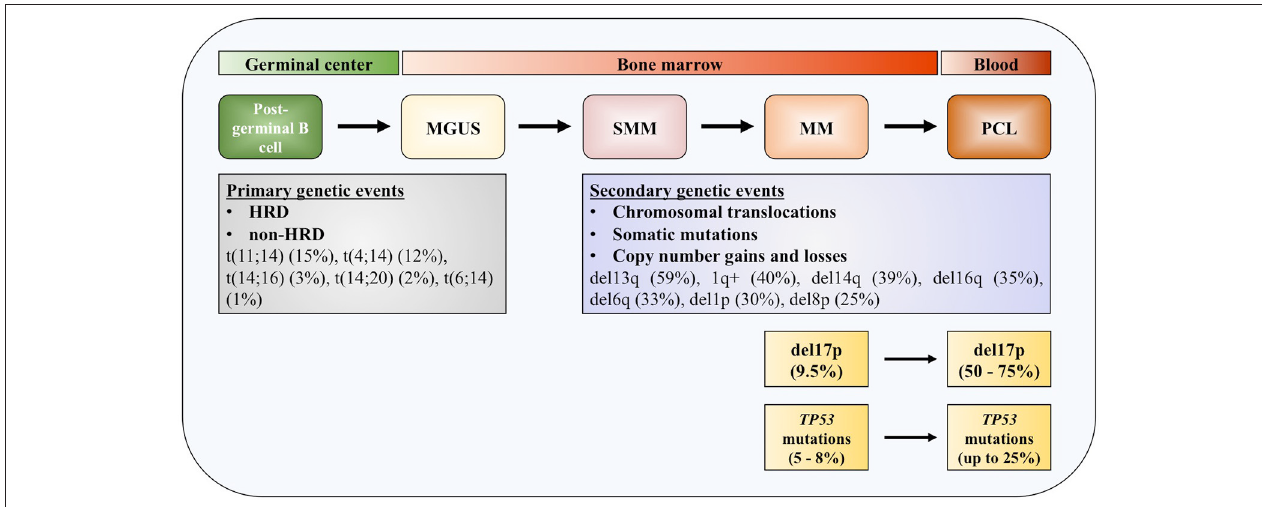
FIGURE 1 | TP53 deregulation in multiple myeloma. Increased incidence of deletion 17p and TP53 mutations across the course of the disease. MGUS, monoclonal gamopathy of undetermined significance; SMM, smoldering multiple myeloma; MM, multiple myeloma; PCL, plasma cell leukemia; HDR,